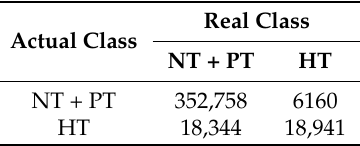
Table 9. The confusion matrix for Random Forest over Risk Stratification between normotension plus prehypertension (NT + PT), as opposed to Hypertension at both stages